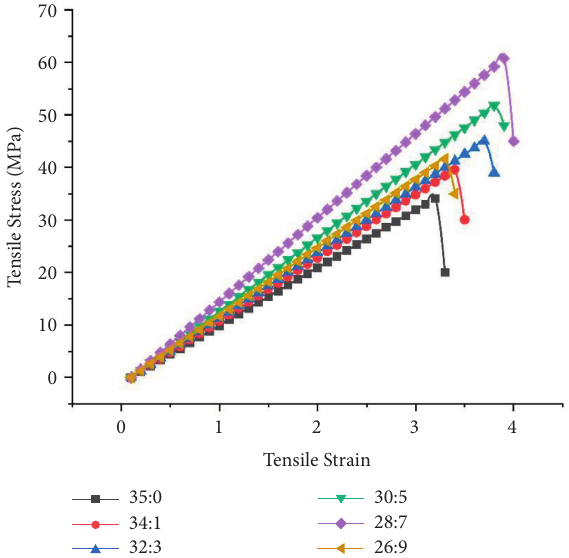
Figure 5: Tensile strain vs. tensile stress curves for epoxy resin/ madar fibre/sugarcane bagasse ash